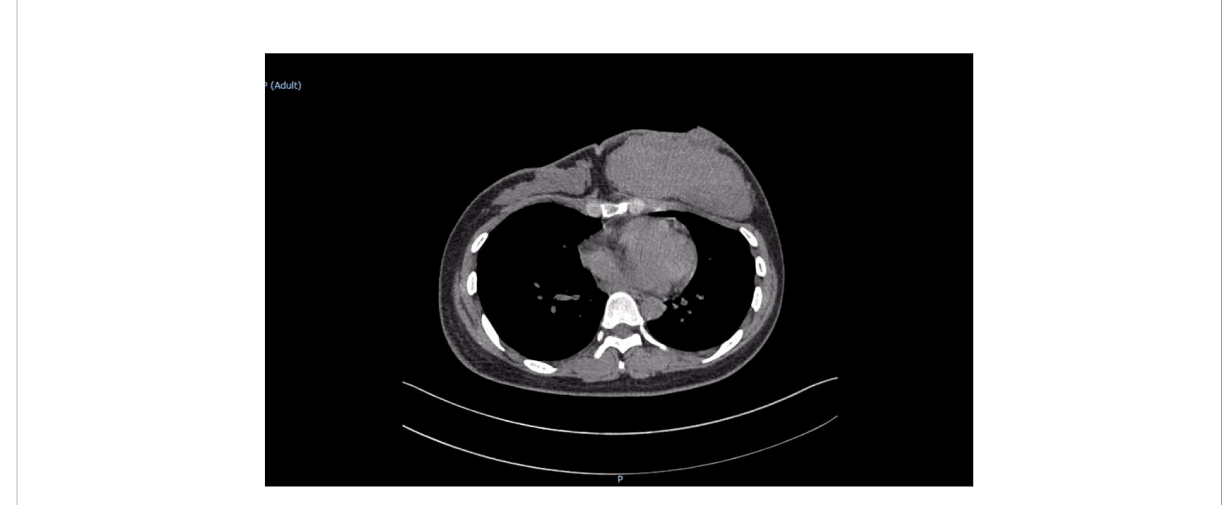
FIGURE 2 Chest computed tomography scan revealed a large soft tissue mass in the left breast with uniform